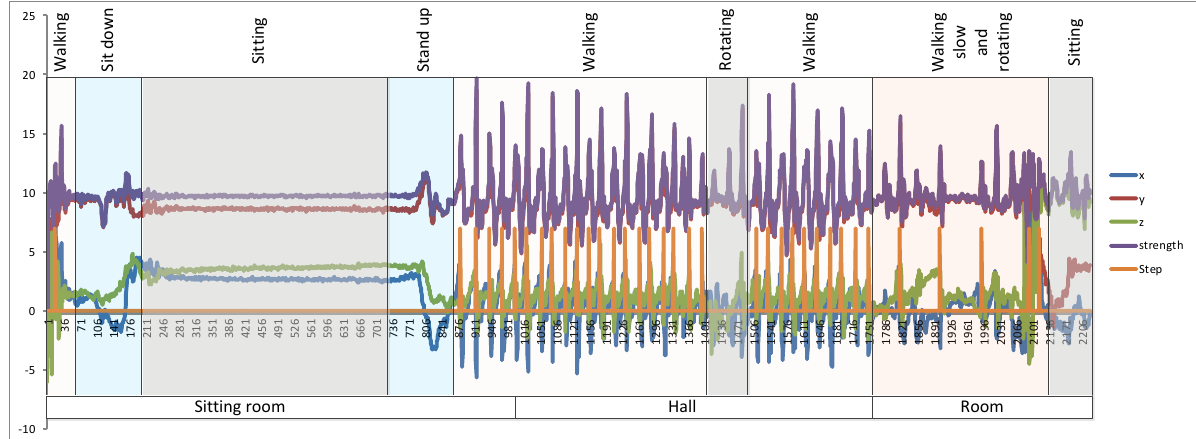
Figure 11. Detection steps based on different